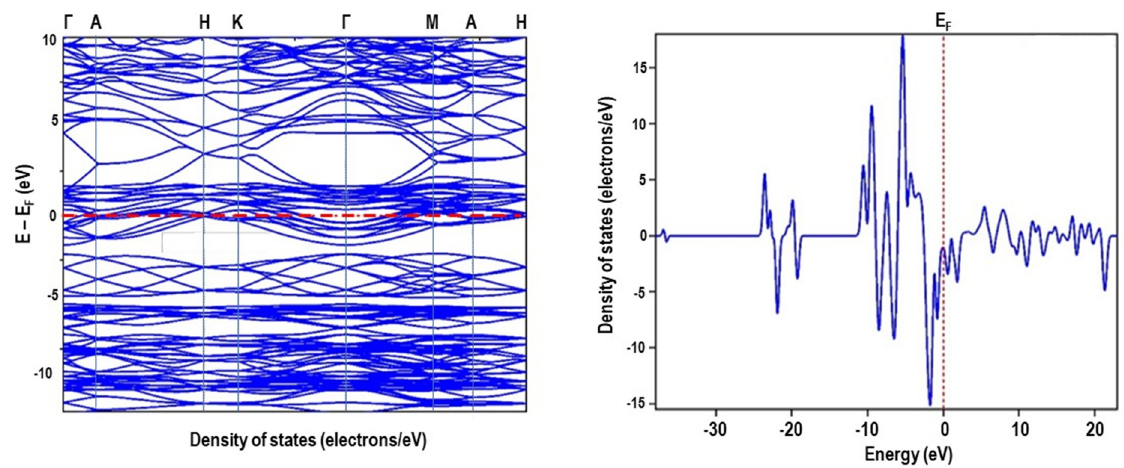
Figure 10. CASTEP GGA–PBE band structure and DOS of rhombohedral perovskite LaMnO 3